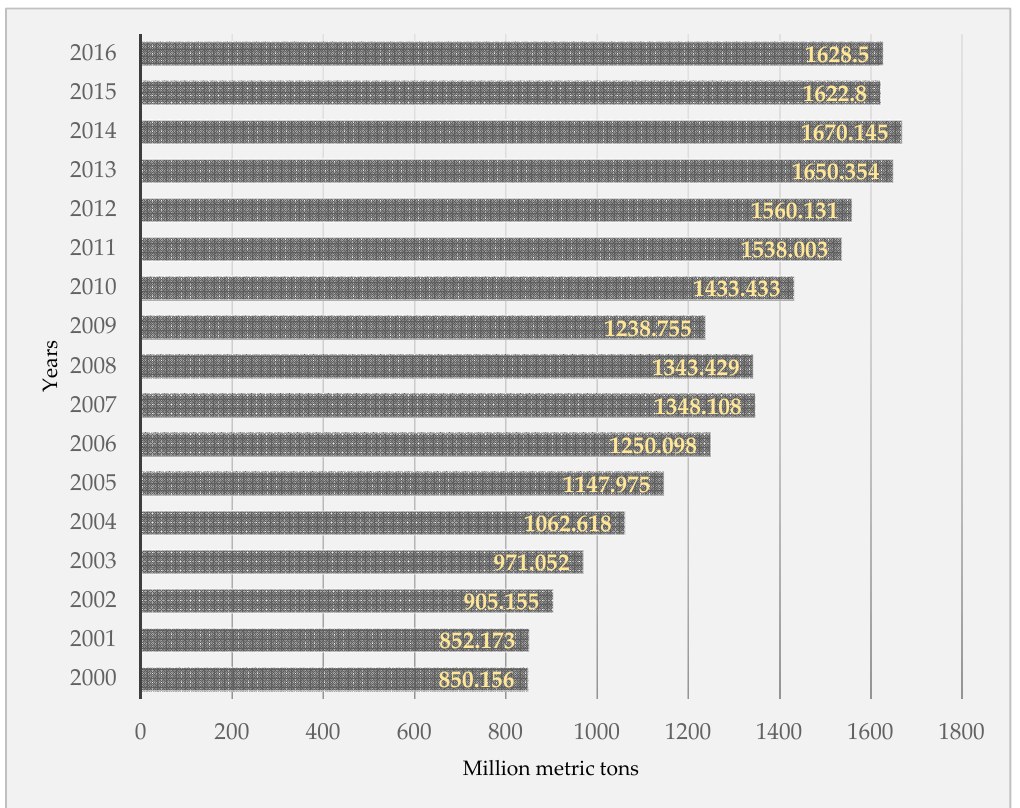
Figure 2. Evolution of Global Steel Production. Figure 2. The evolution of car